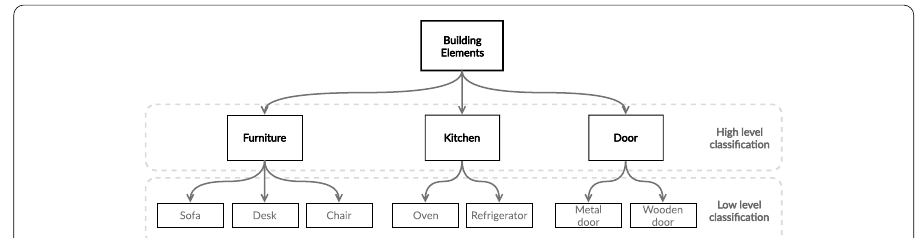
Fig. 7 Example of different classification levels